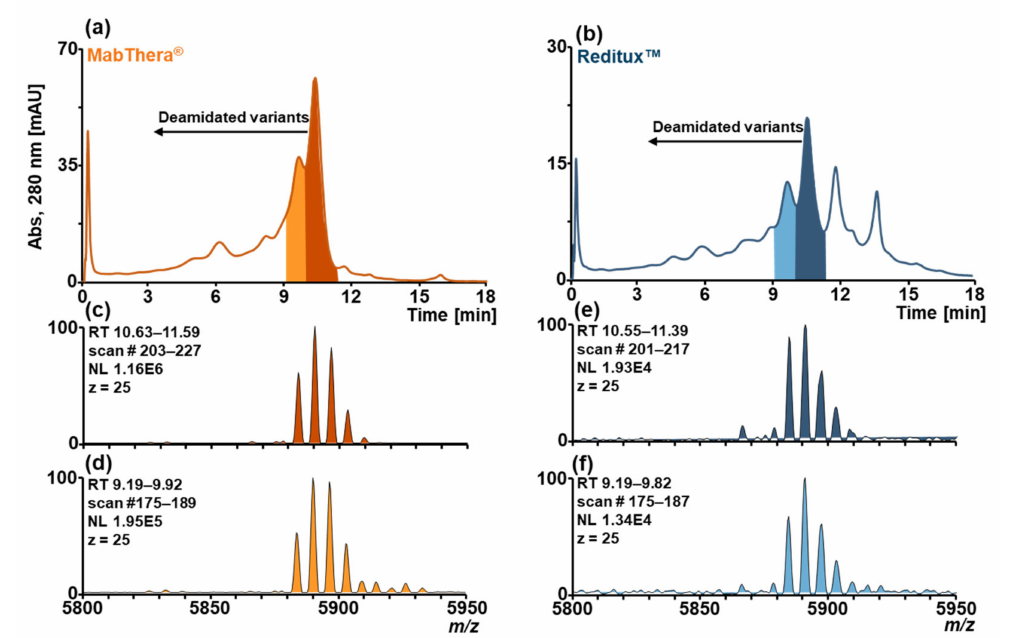
Figure 2. SCX-HPLC-MS chromatograms of forced deamidated ( a ) MabThera ® (orange) and ( b ) Reditux™ (blue). Additional chromatographic peaks due to deamidated variants are indicated. Magnification of charge state 25+ of the mass spectrum associated with ( c ) the peak at RT 10.63–11.59 min of MabThera ® , ( d ) the peak at RT 9.19–9.92 min of MabThera ® , the peak at RT 10.55–11.39 min of Reditux™, and ( f ) the peak at RT 9.19–9.82 min of Reditux™. No clear differences can be observed between the spectra ( c , d ) and ( e , f ) due to the inability of MS to resolve the mass shift of deamidation ( ≈ 1 Da) at the intact